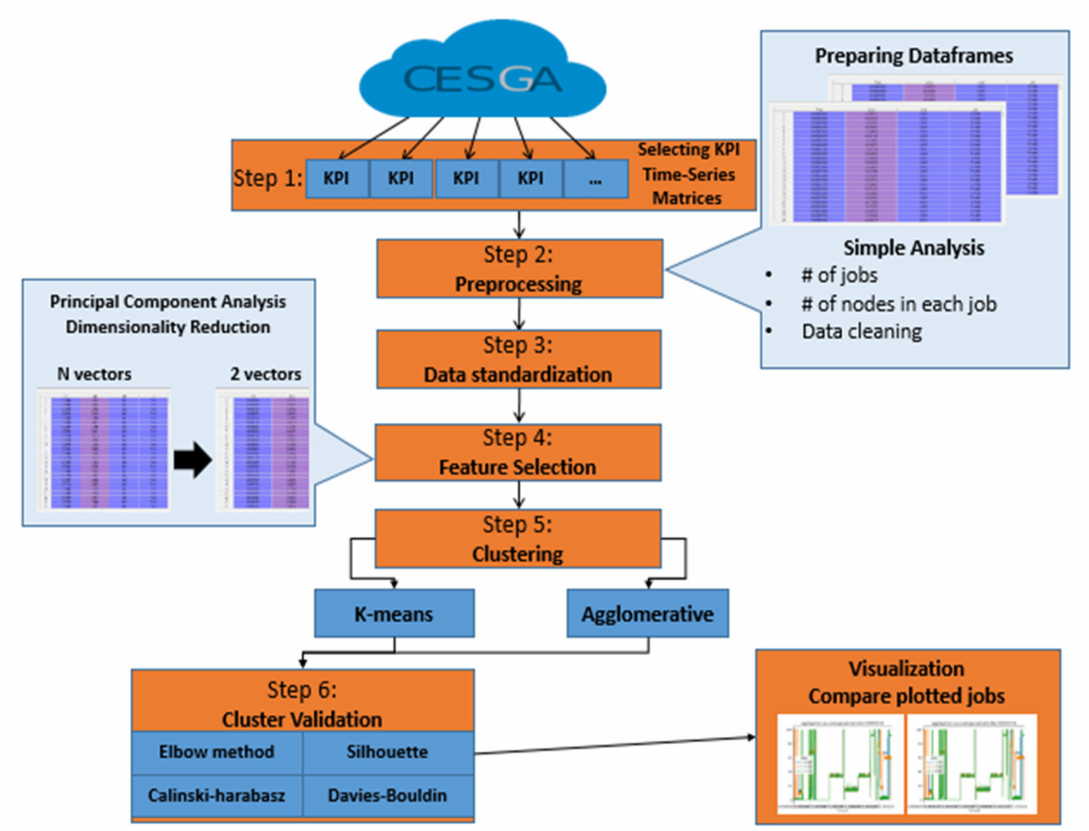
Figure 1. Framework for clustering high-performance computing (HPC) jobs key performance indicators (KPIs) using feature